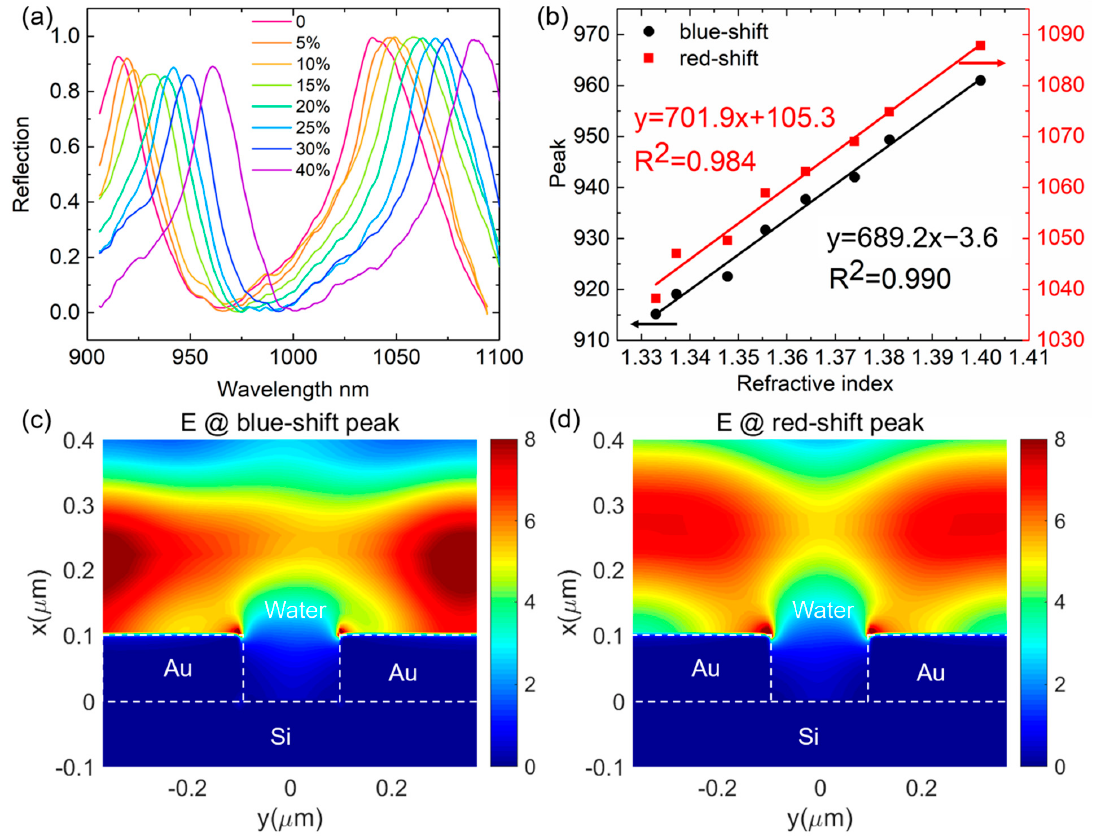
Figure 8. The refractive sensitivity of gold gratings on silicon. ( a ) The reflection spectra of gold gratings immersed in different concentrations of sucrose in water. ( b ) The linear fitting of the blue-shift and red-shift peak position to refractive index. The electric field enhancement distribution of blue-shift and red-shift peak is shown in ( c ) and ( d ), respectively.